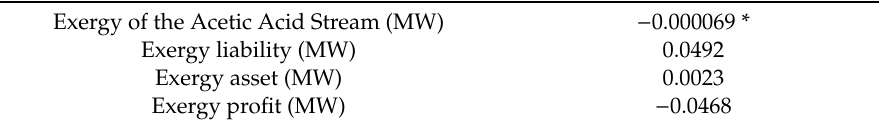
Table 4. Calculation results of input acetic acid stream, on the basis of a value of 100 kg / h of the acetic acid input